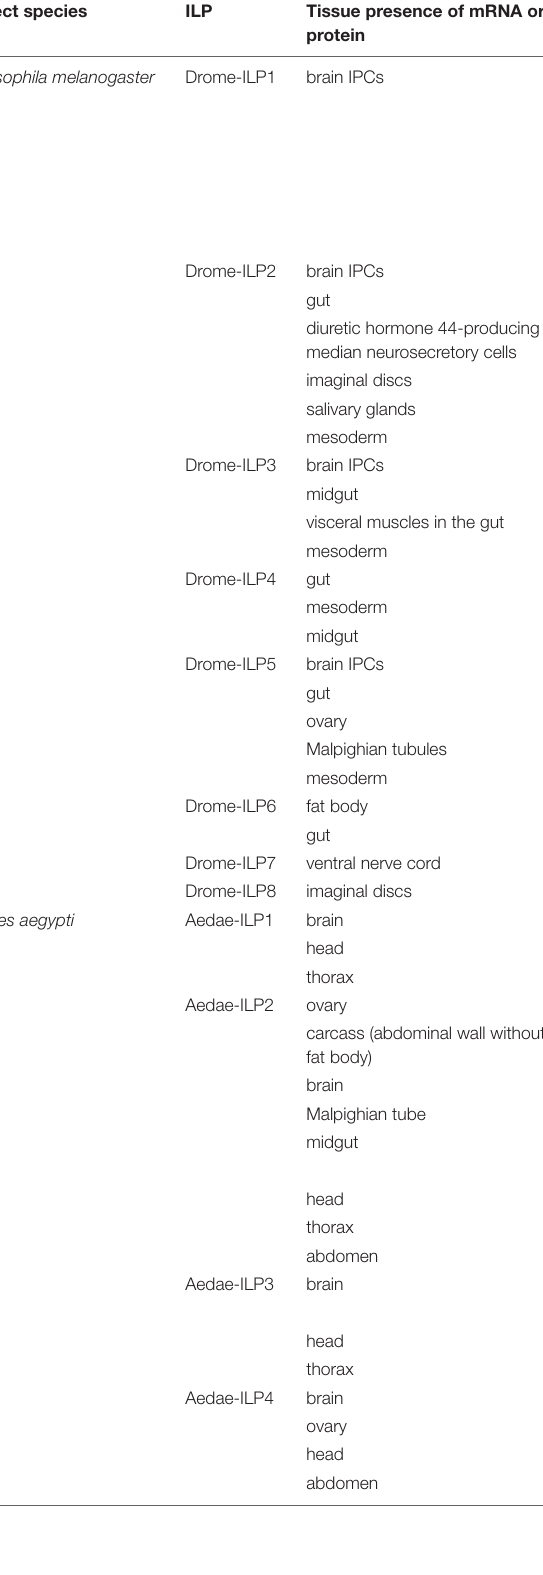
TABLE 1 | Examples of ILPs expressed in different tissues/cells depending on the developmental stage. Insect species